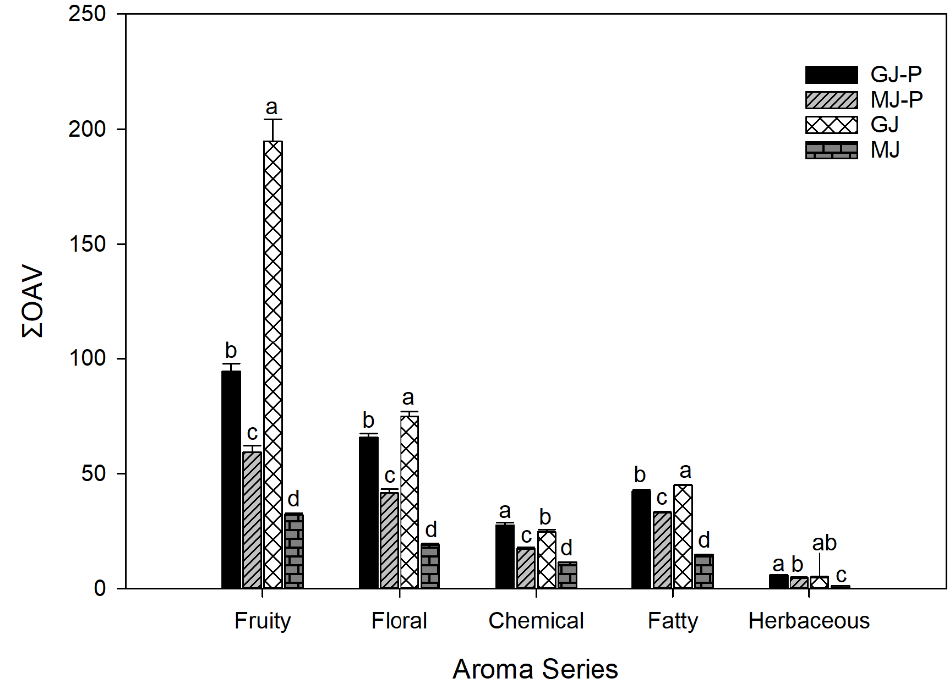
Figure 1. Comparison of aroma series based on Σ OAV between four treatments. Different letters in the same aroma series means a significant difference ( p < 0.05). GJ-P, grape juice plus pomace; MJ-P, model juice plus pomace; GJ, grape juice; MJ, model juice.